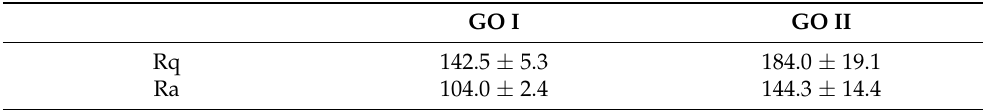
Figure 7. Three-dimensional AFM images of gold electrodes modified with graphene oxides: GO I ( left ) and GO II ( right ) suspensions. Table 1. Surface roughness parameters calculated from AFM